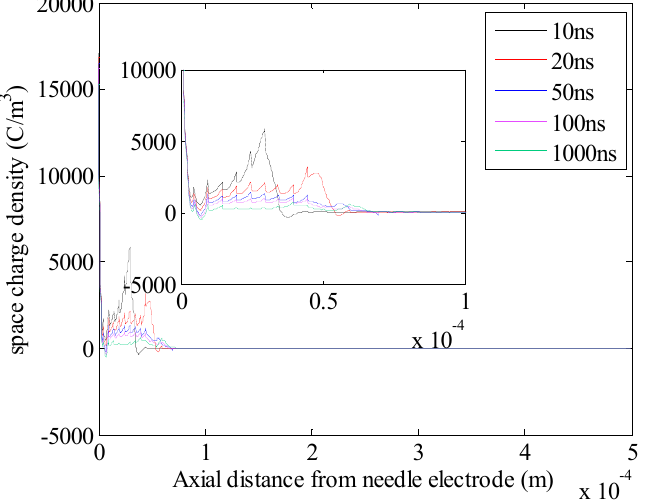
Figure 7. Space charge density distribution along the needle-sphere axis as a response to 1.2 PDIV with 10 mm needle-sphere electrode configuration.